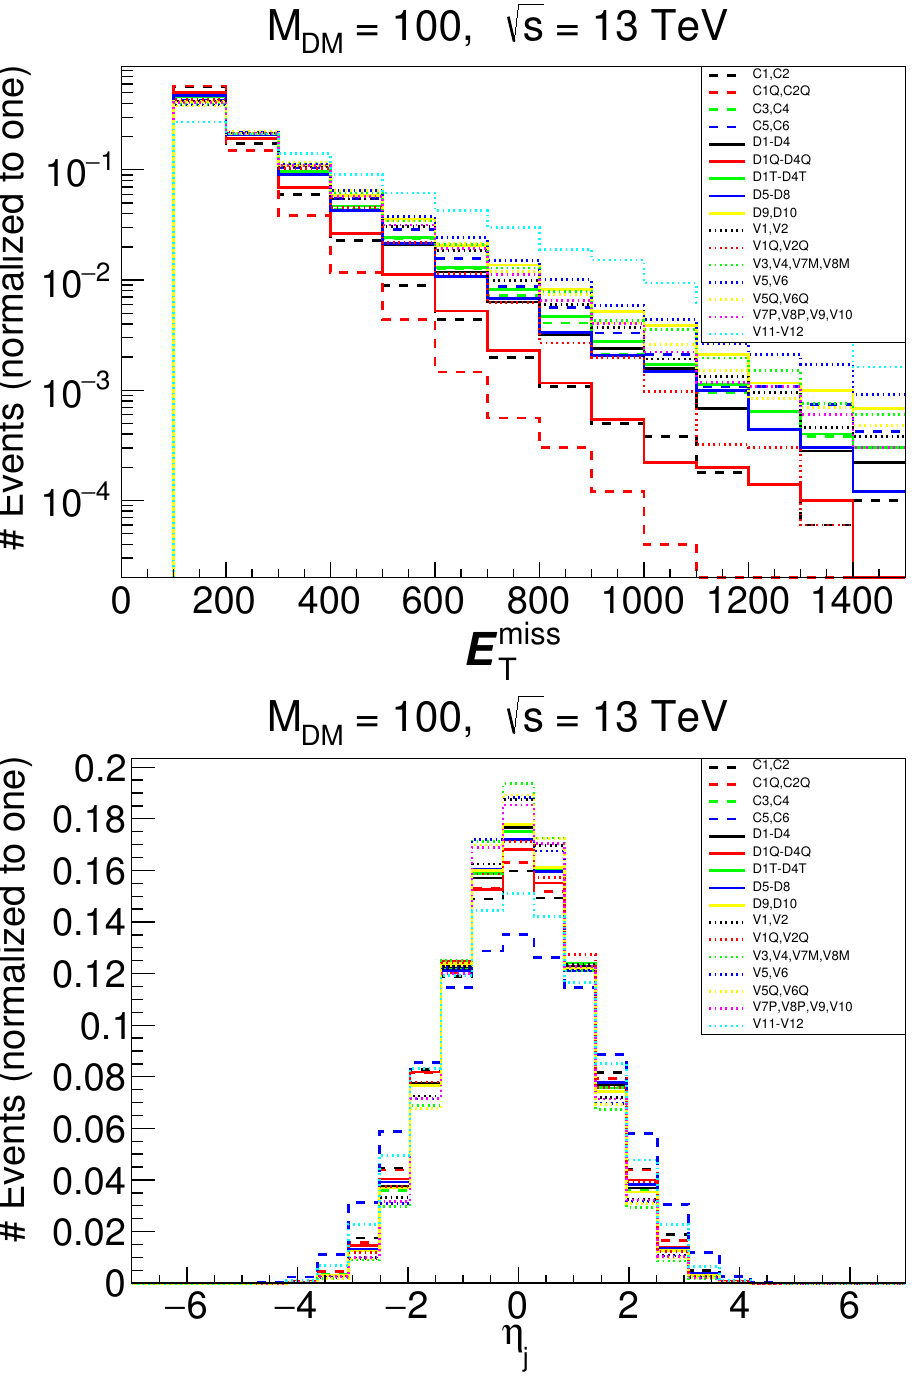
Figure 7 . E miss and Jet pseudo-rapidity distributions at the detector level, for representative EFT T operators from the classes in tables 1 and 2. In all plots M DM = 100 GeV and the collision energy is 13 TeV.